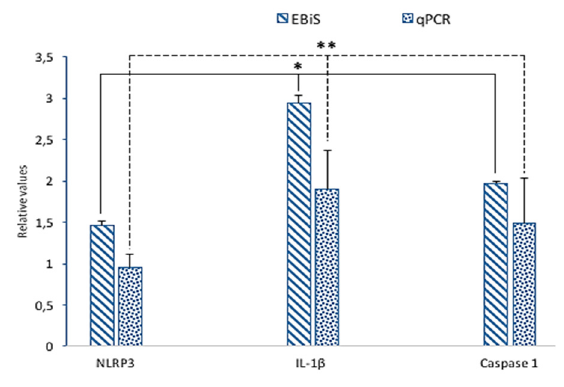
Fig. 4. Relative integrated EBiS vs relative qPCR expression of the genes NLRP3, IL-1β, and Casp-1. One-way ANOVA test *p<0.01,